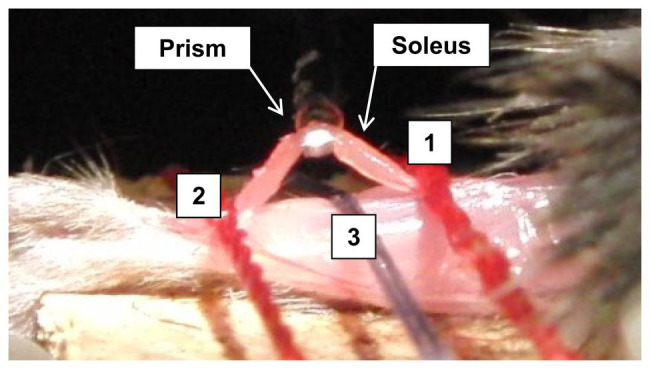
Illustration of the prism with light source underneath the isolated soleus bundle, where the isolated soleus muscle was held down during the biomechanical testing. Line 1 and line 2 are the position, where a suture holds down the isolated soleus muscle. Line 3 is the midpoint location, where another suture holds down the leg.